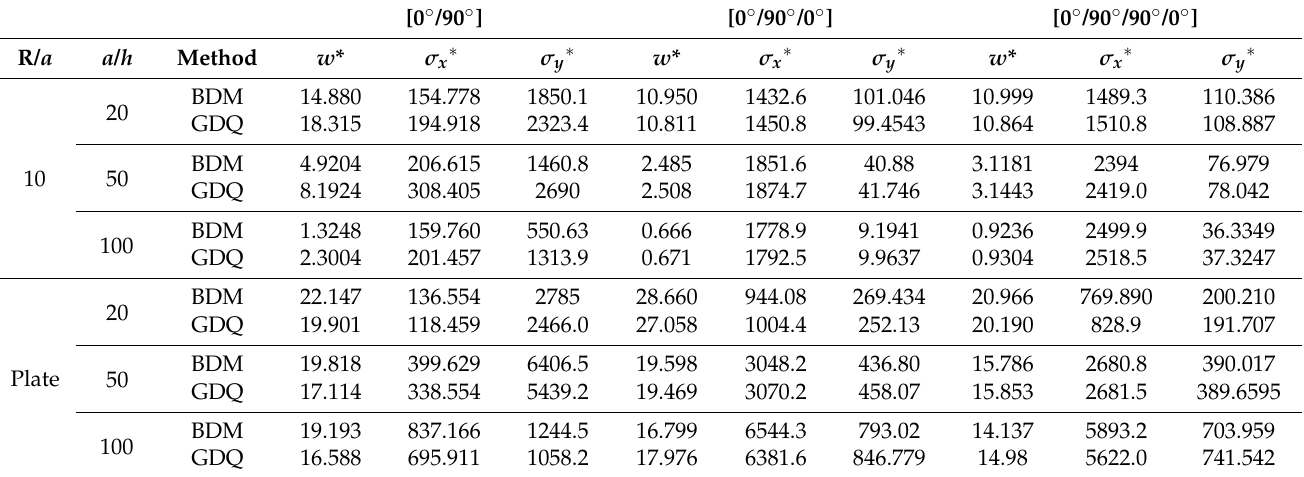
Table 3. Normalized central deflections of cross-ply laminated shells under uniform load.